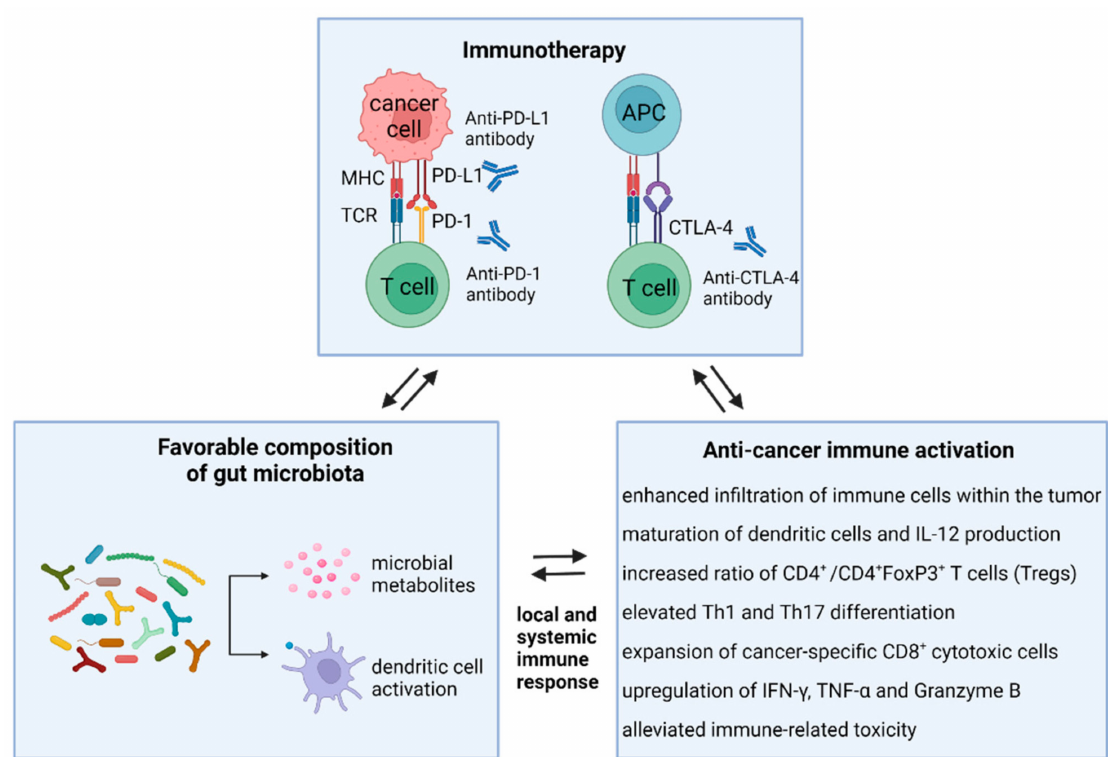
Figure 2. Modulatory effects of favorable gut microbiota on the immune system and immunotherapy efficacy. Microbiota-directed activation of anti-cancer immunity significantly affects the response of cancer patients to immunotherapy with immune checkpoint inhibitors (anti-PD-1, anti-PD-L1, or anti-CTLA4). The host immune response is triggered by microbiota-derived metabolites, like SCFA, and by recognition of bacterial signals with dendritic cells. Subsequently, T cell priming, depending mainly on the cytokine milieu, leads to T cell differentiation into immunosuppressive Treg cells, Th1/Th17 cells, and effector T cells. Th1 CD4 + T cell differentiation and activation of CD8 + cytotoxic cells result in the production of specific cytokines and tumor killing. Abbreviations: IFN- γ , interferon gamma; TNF- α , tumor necrosis factor α